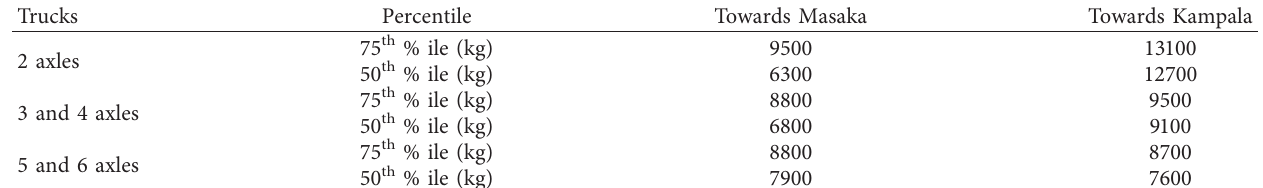
Table 2: Percentile axle loads.